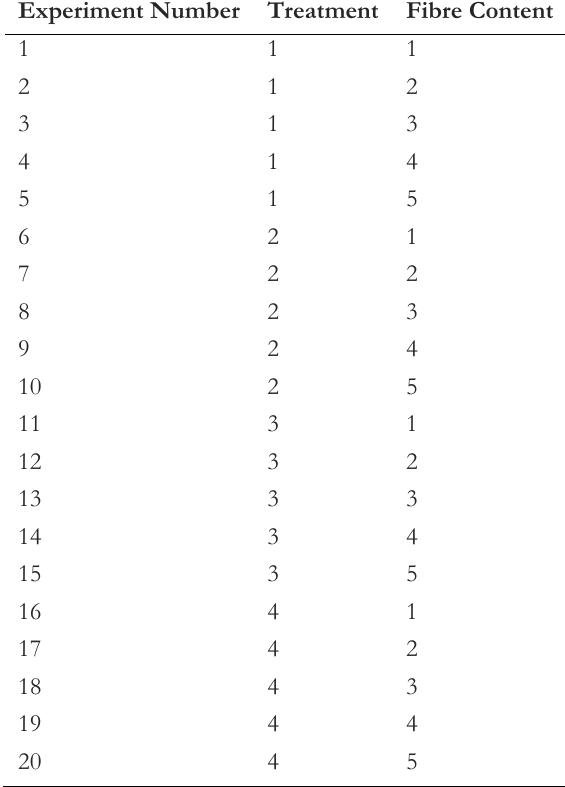
Table 2. L20-OA design matrix for composite